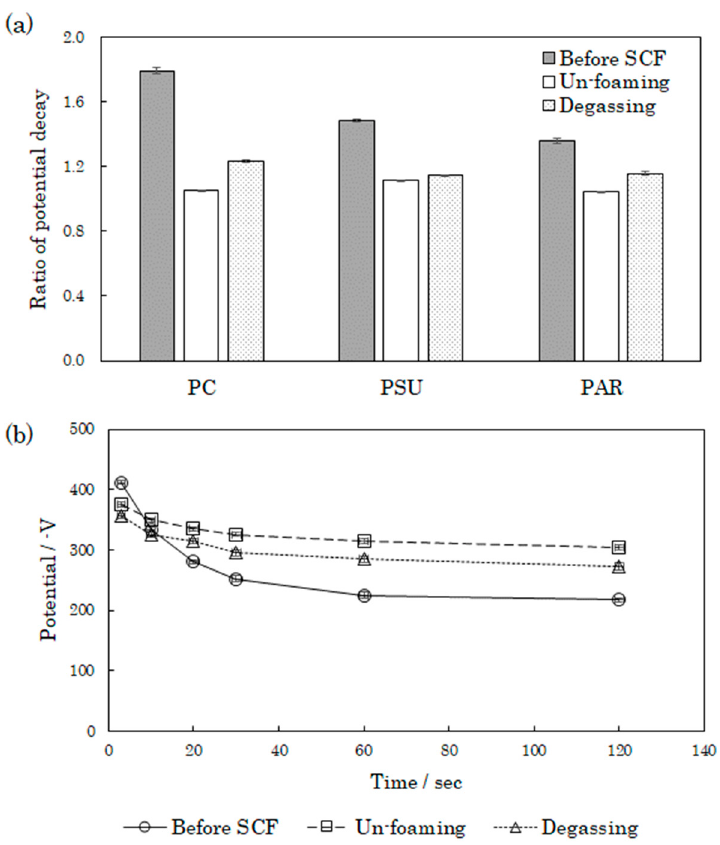
Figure 7. Electrical properties of di ff erent engineering plastics: ( a ) potential decay and ( b ) potential decay curve.